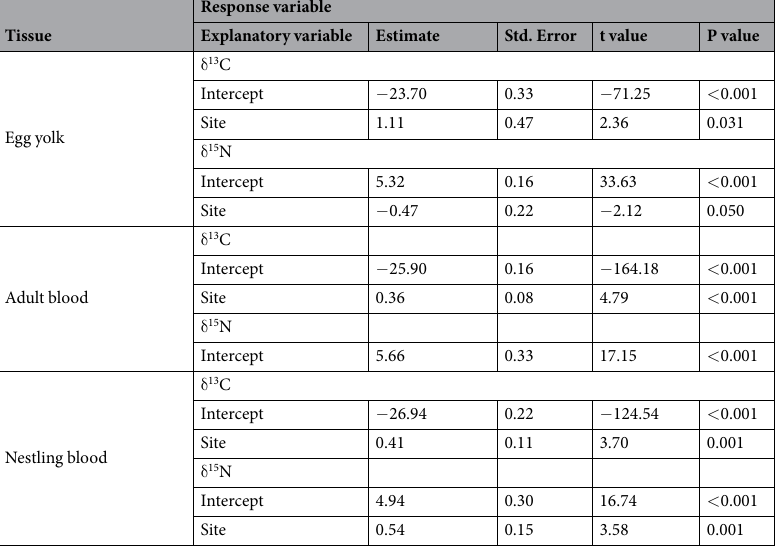
Table 6. Results from LM analysis of stable carbon and nitrogen isotope signatures ( δ 13 C and δ 15 N), after backward selection. Sampled tissues were eggs, and whole blood of adult and nestling blue tits. Initial explanatory variables were always site and date, and also sex for adult samples, and were dropped if not significant via backward selection (only significant variables are shown).